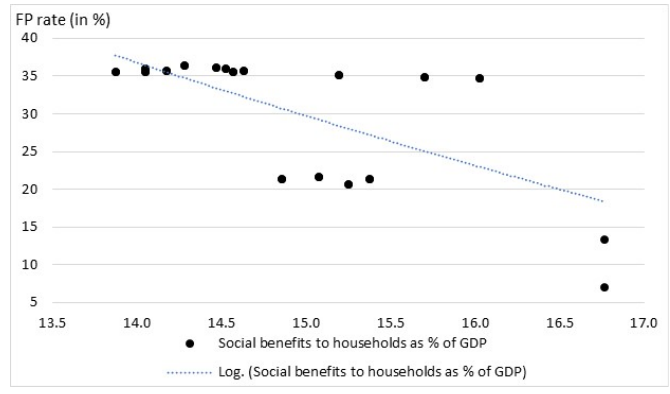
Figure 3. Fuel poverty rate versus social benefits to households in Poland in 2004–mid ‐ 2021.